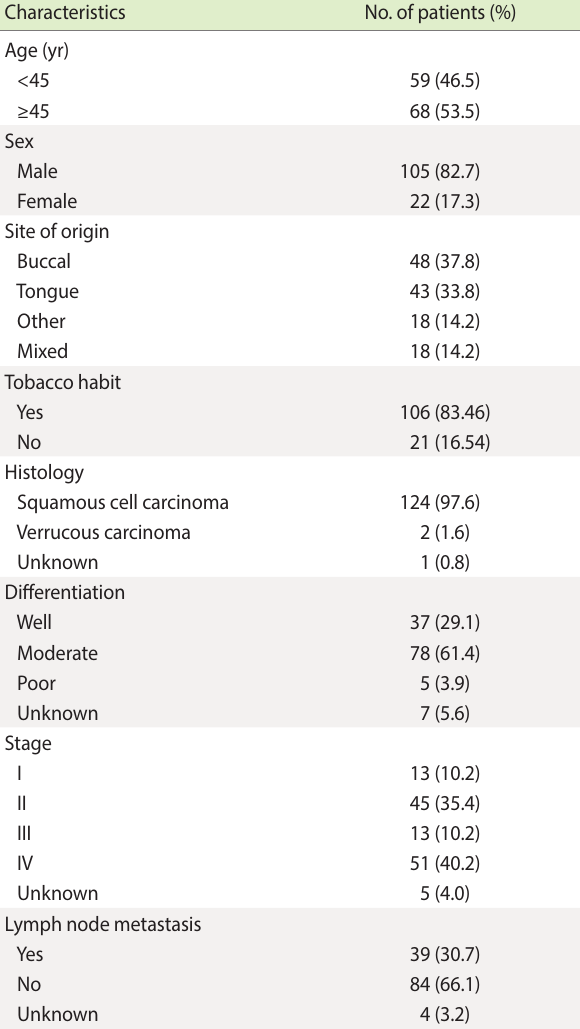
Table 3. Clinical and clinicopathological details of the oral cancer cohort Characteristics